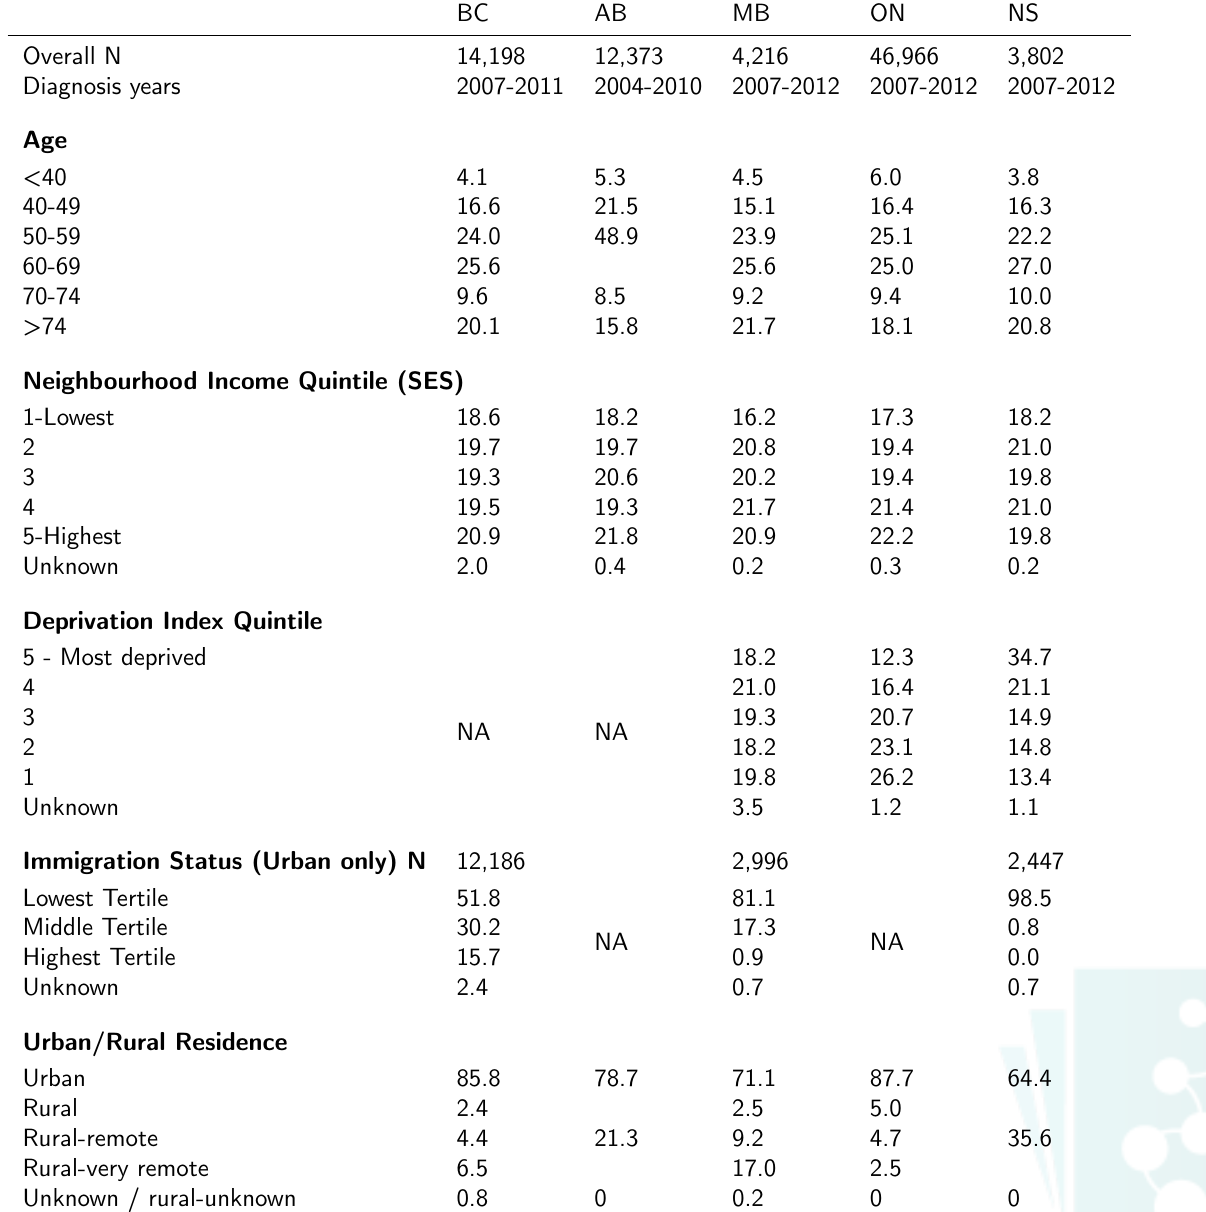
Table 1: Demographic characteristics of the CanIMPACT provincial breast cancer cohorts